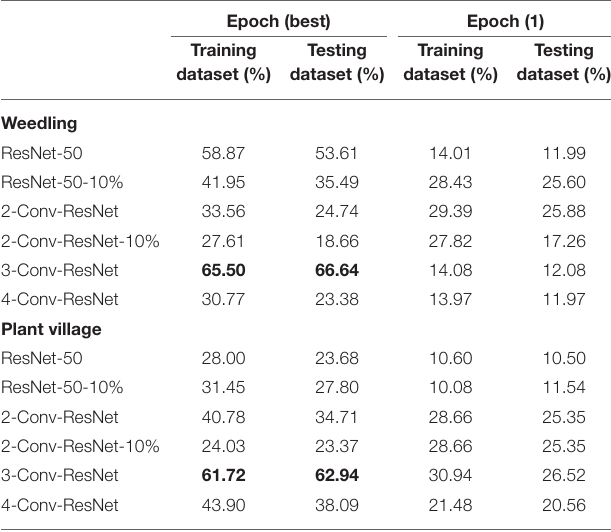
TABLE 2 | Performances of ResNet-50 model with different block for various datasets with segmented images.